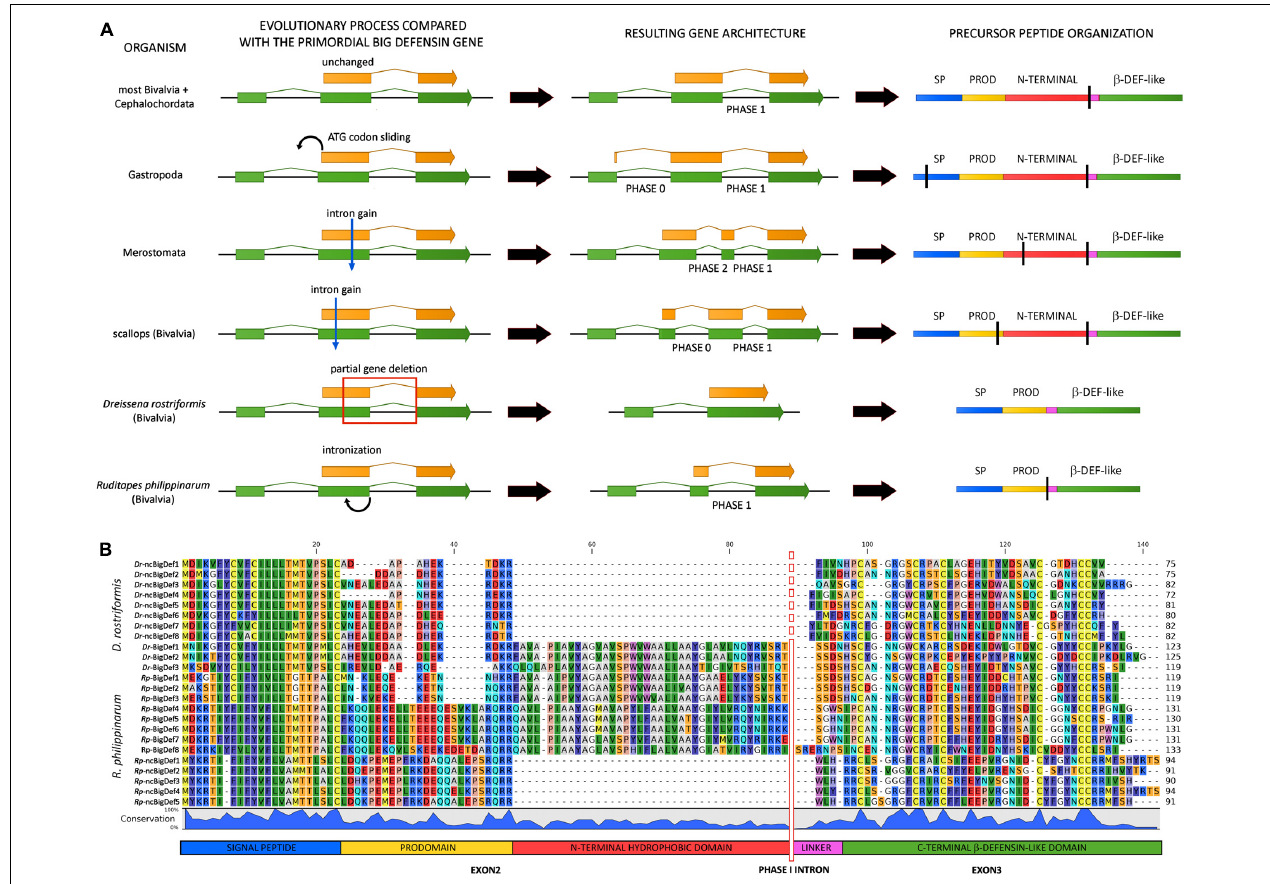
FIGURE 4 | Inferred evolutionary processes that may have led to the big defensin gene architecture observed in extant metazoan taxa. (A) mRNAs are indicated by green arrows and protein-coding regions are indicated with orange arrows. On the right-hand side, a schematic organization of the encoded precursor peptides is shown, including the signal peptide (SP), prodomain (PROD), N-terminal hydrophobic domain, linker and C-terminal β -defensin-like domain. Vertical black bars highlight the positioning of introns. (B) Multiple sequence alignment of the canonical (BigDefs) and non-canonical (ncBigDefs) big defensin peptides identified in the genomes and transcriptomes of Dreissena rostriformis and Ruditapes philippinarum . The organization of the main regions of the precursor peptides is shown at the bottom of the figure. The location of the phase I intron is indicated by a vertical bar (dashed in Dr -ncBigDefs, where it was lost). Note the large deletion of the N-terminal region which characterizes the non-canonical genes of both